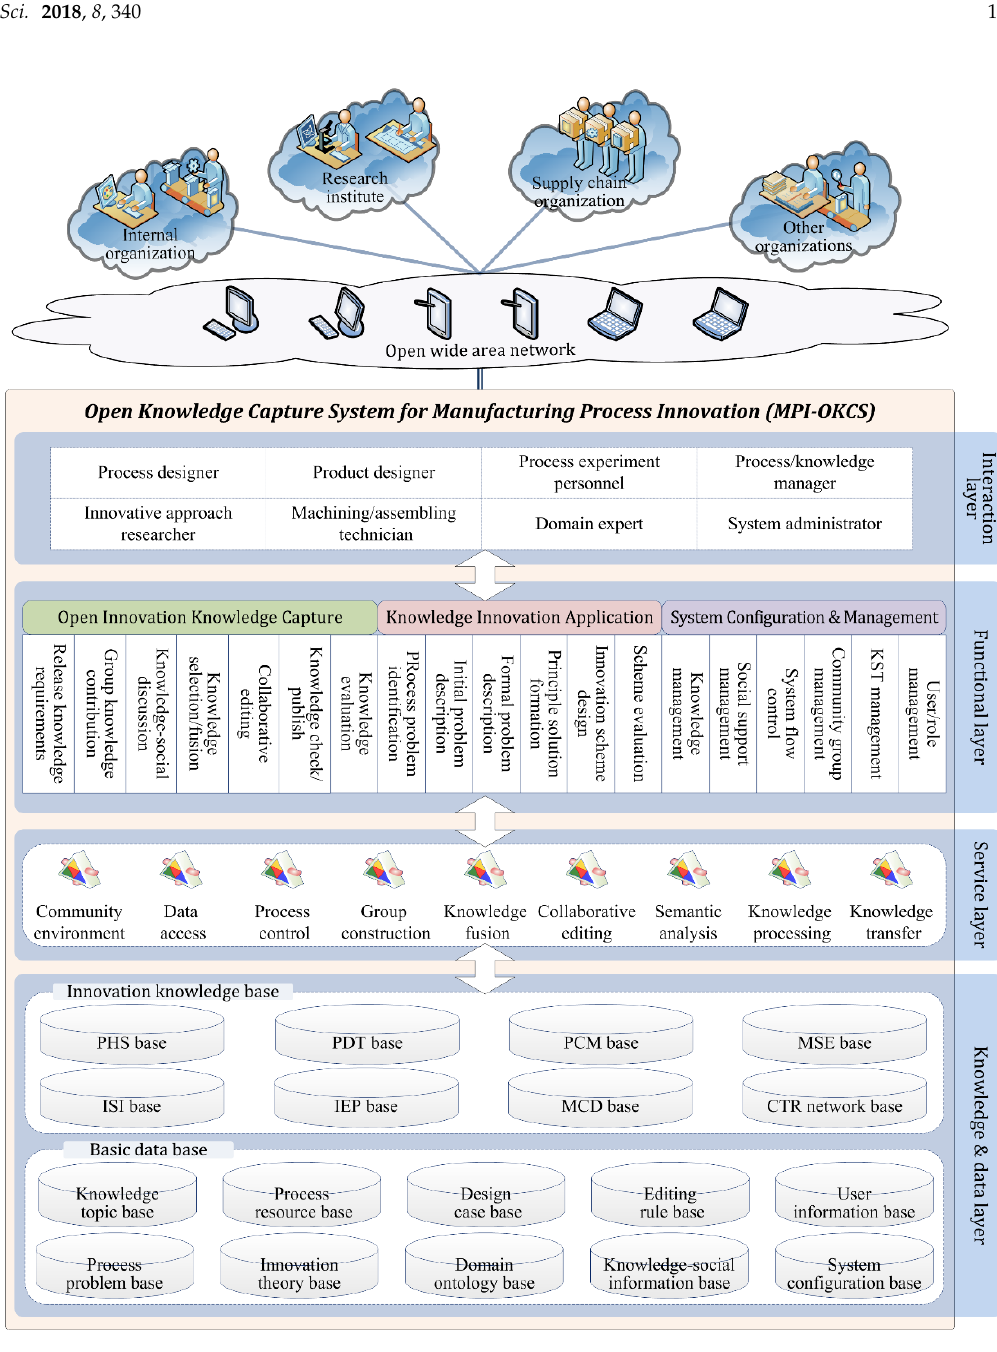
Figure 5. The system architecture of MPI-OKCS .